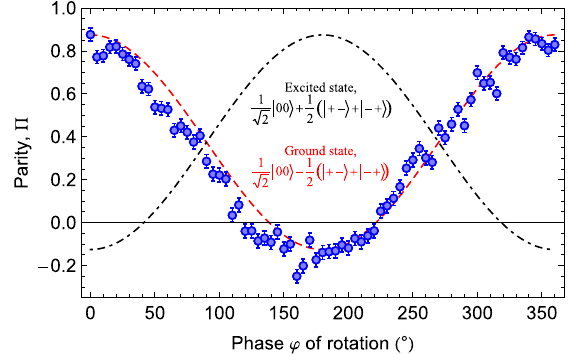
FIG. 4. Measurements of the prepared two-spin states (narrow blue bars) after ramping an ð S z Þ 2 field, compared to the values expected for the calculated ground state (gray bars). As in Fig. 2(a) – (c) show the measured populations when the dark state is set to be j 0 i , j − i , or jþi , respectively.